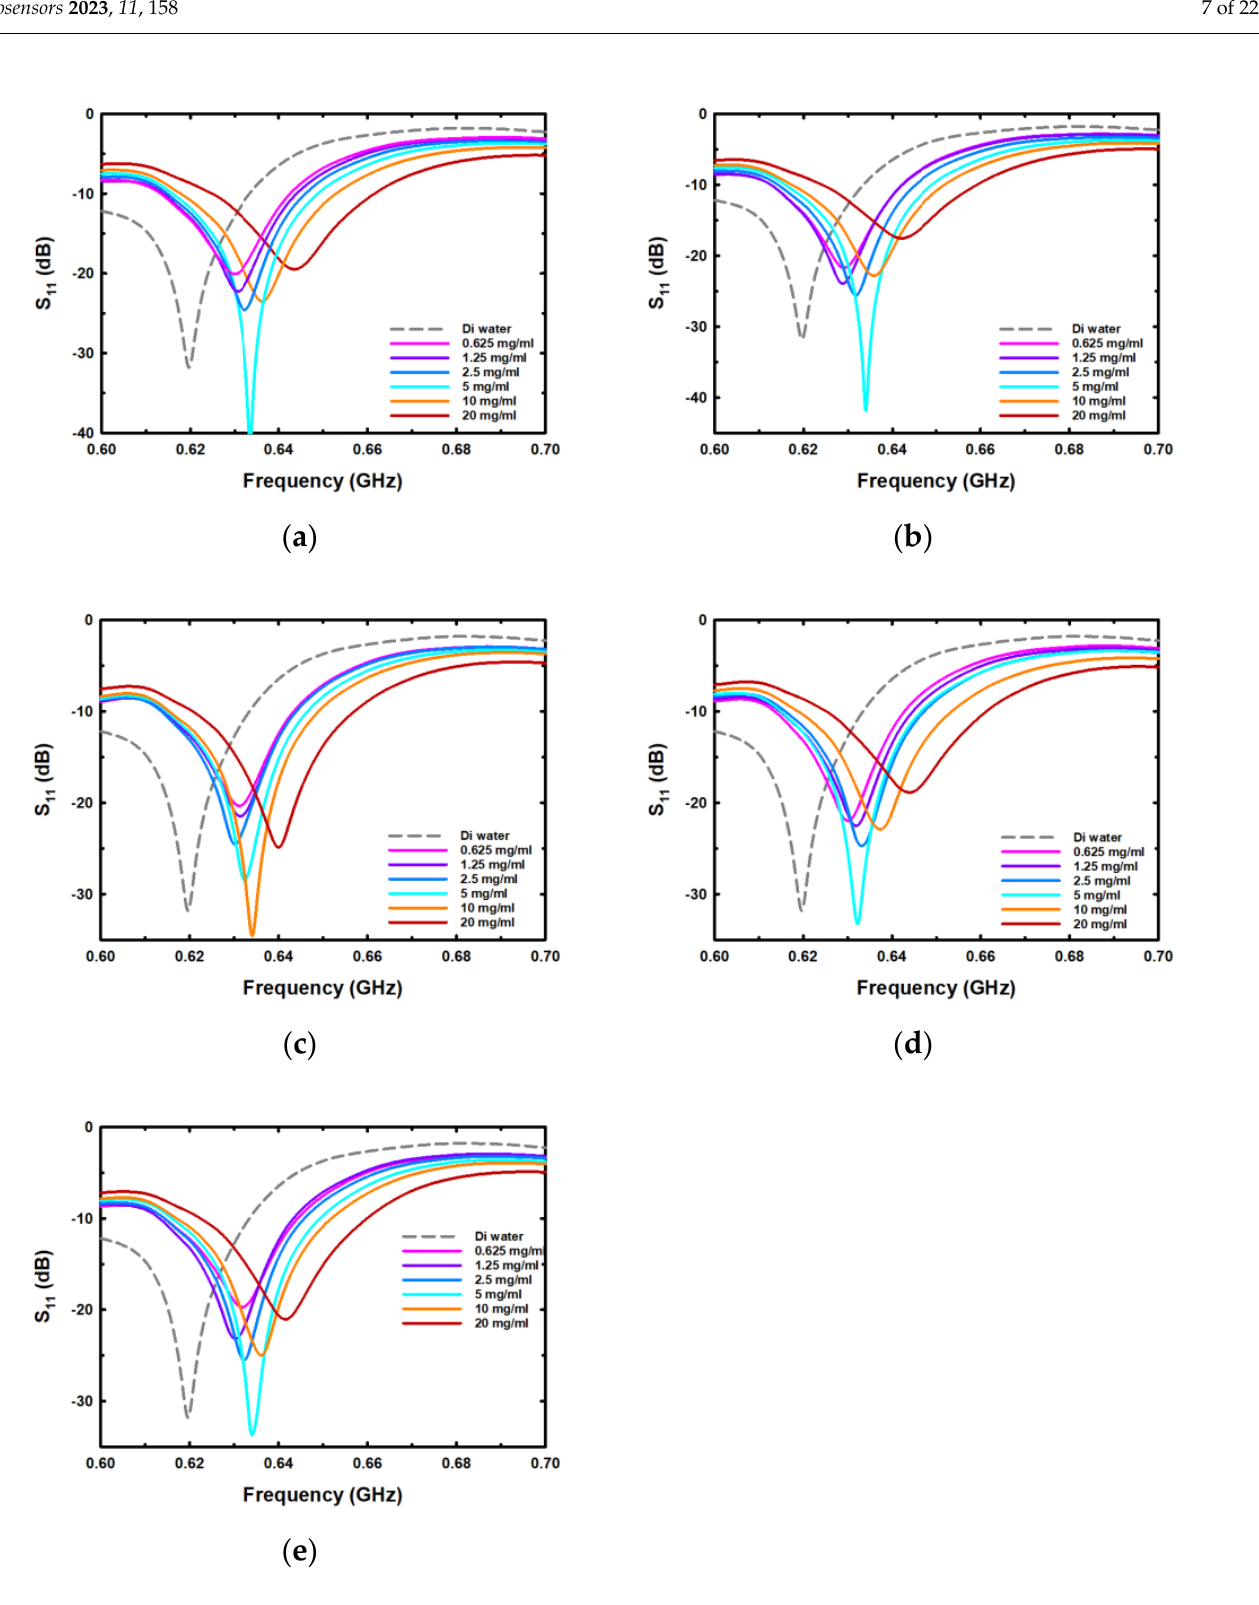
Figure 5. The reflection coefficient spectra in the frequency range from 0.6 GHz to 0.7 GHz for the second resonance peak for different concentrations of ( a ) sodium chloride (NaCl), ( b ) potassium chloride (KCl), ( c ) magnesium chloride (MgCl 2 ), ( d ) calcium chloride (CaCl 2 ), and ( e ) sodium carbonate (Na 2 CO 3 ).